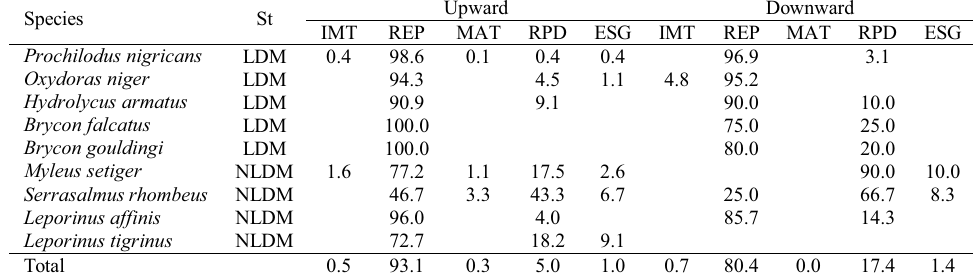
Table 2. Frequency (%) of gonadal development stages of females of the principal species moving up and down the Lajeado fish ladder, during the period from June, 2004 through March, 2005. (St = Reproductive strategy; LDM = long-distance migratory; NLDM = non-long-distance migratory; IMT = immature; REP = resting; MAT = maturation; RPD = reproduction; ESG =